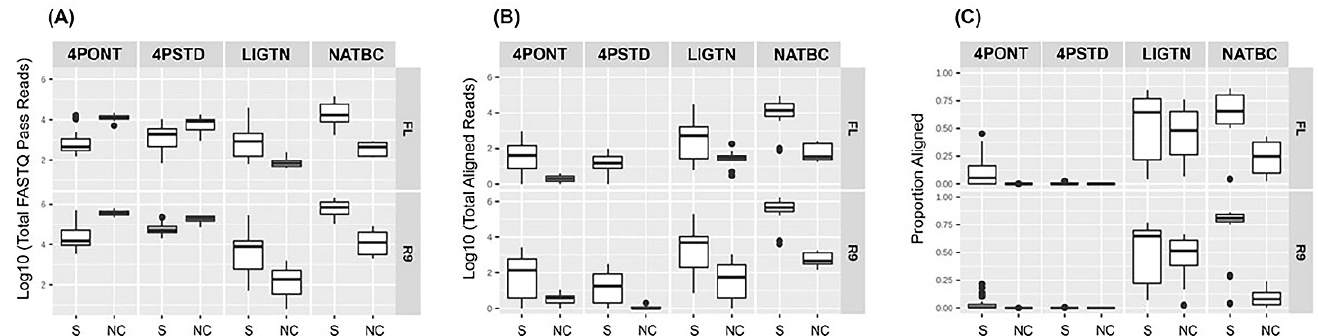
Figure 2. Output read and alignment counts. Read counts from 24 h of sequencing from R9/FL flow cells and the four library prep methods, split into samples spiked with target organism gDNA (0) and NTC (1) groups. ( A ) Total “fastq_pass” read counts (reads with ≥ 7 average PHRED quality score). ( B ) Total BLASTN aligned “fastq_pass” reads to the amplicon reference database post-filtering ( ≥ 90% identity and alignment length). ( C ) The same as ( B ) but displayed as a proportion of ( A ) per method and flow cell type.